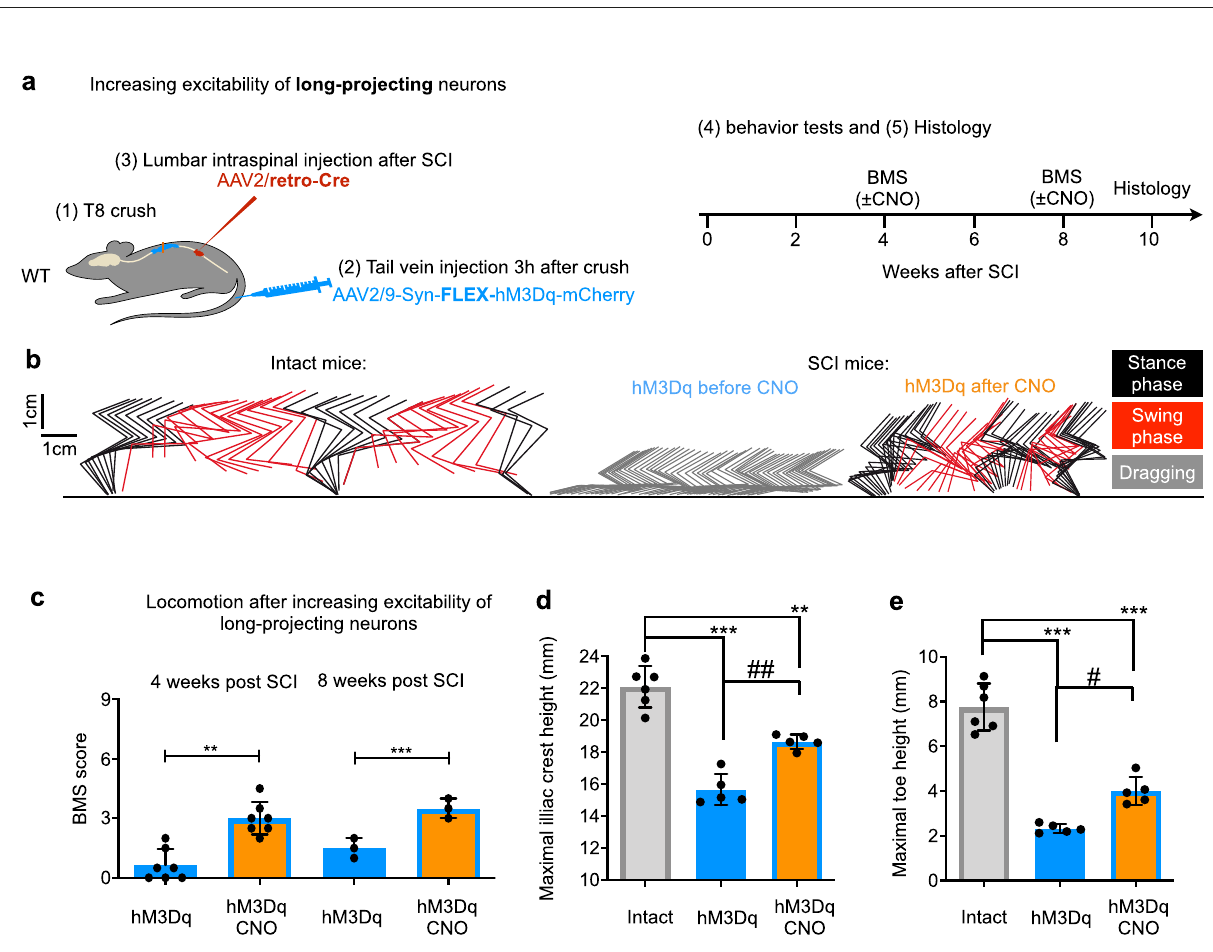
Fig. 5 Activation of propriospinal neurons that project from thoracic to lumbar levels elicits locomotor behavioural recovery after T8 crush. a Experimental schematic of the intersectional strategy of limiting hM3Dq expression to propriospinal neurons projecting to lumbar spinal cord. b Stickviews of kinematic analysis of intact mice and injured mice with targeted expression of hM3Dq in long-projecting neurons before and during CNO (1 mg/kg). The phases of dragging, stance, or swing were marked in indicated colours. Data from intact mice are replotted from Fig. 2c for comparison. c BMS scores of mice with targeted expression of hM3Dq in long-projecting neurons at 4 and 8 weeks after injury, before and 1 h after application of 1 mg/ kg CNO. Data shown as mean ± SD. Two tailed paired t test. ** p = 0.0002 (4 weeks) *** p < 0.0001 (8 weeks). n = 7 (4 weeks) and n = 3 (8 weeks). Quanti fi cation of the maximum iliac crest heights ( d ) and the maximum toe height ( e ). n = 6 (intact) and n = 5 (hM3Dq). Data from intact mice are replotted from Fig. 2e, f for comparison. Shown are means ± SD. Two tailed paired t test for within-group comparison (#) and two sample t test for between-group comparison (*). ## p = 0.0030, ** p = 0.0003, *** p < 0.001 and # p = On the other hand, in all Vgat-Cre mice with hM4Di expression, extensors was observed, and (2) in Vgat-Cre mice with hM4Di we observed extension of the hindlimbs behind the body and expression, non-stopping co-activation of ankle extensor and fl exor muscles occurred (Supplementary Fig. 9d, f). Such different continuous bilateral spasms. EMG recordings revealed random fi ring of all muscle groups forms of spasms were unlikely due to the variation in surgical tested, but with some differences: (1) in both wild-type and injection, as the same procedure was used in all mice (one Vglut2-Cre mice with hM3Dq expression, strong activation of hip example of viral mediated tdTomato expression in lumbar spinal